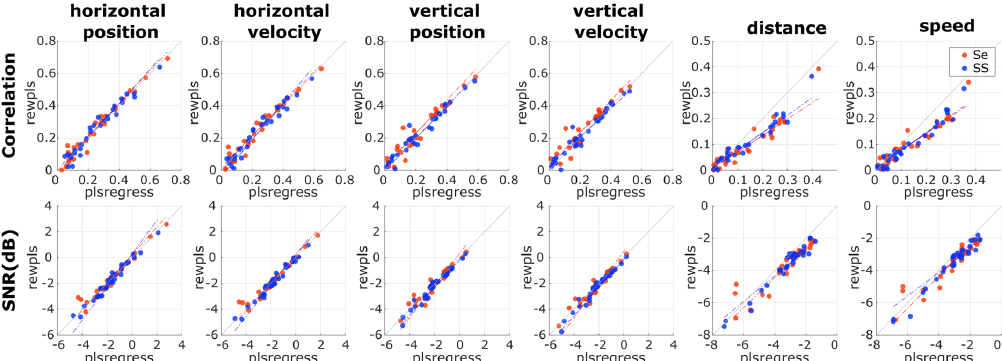
Figure 2. Scatter plots of the participant-level corresponding performance metrics (correlation and SNR) between REWPLS and PLSREGRESS. The metrics from all measurement blocks (0–100% EEG) are plotted in the same scatter plot, resulting in a total of 30 points (10 participants × 3 measurement blocks). The dashed line represents the linear trend of the corresponding points, while the black identity (where x = y) line represents the ideal line, where the performance of REWPLS and PLSREGRESS is the same. The orange and blue colors represent the performance metrics from 2 different feature types: sensor-space (Se) and source-space (SS) features. Note that the distance and speed have different scaling from the other kinematics.